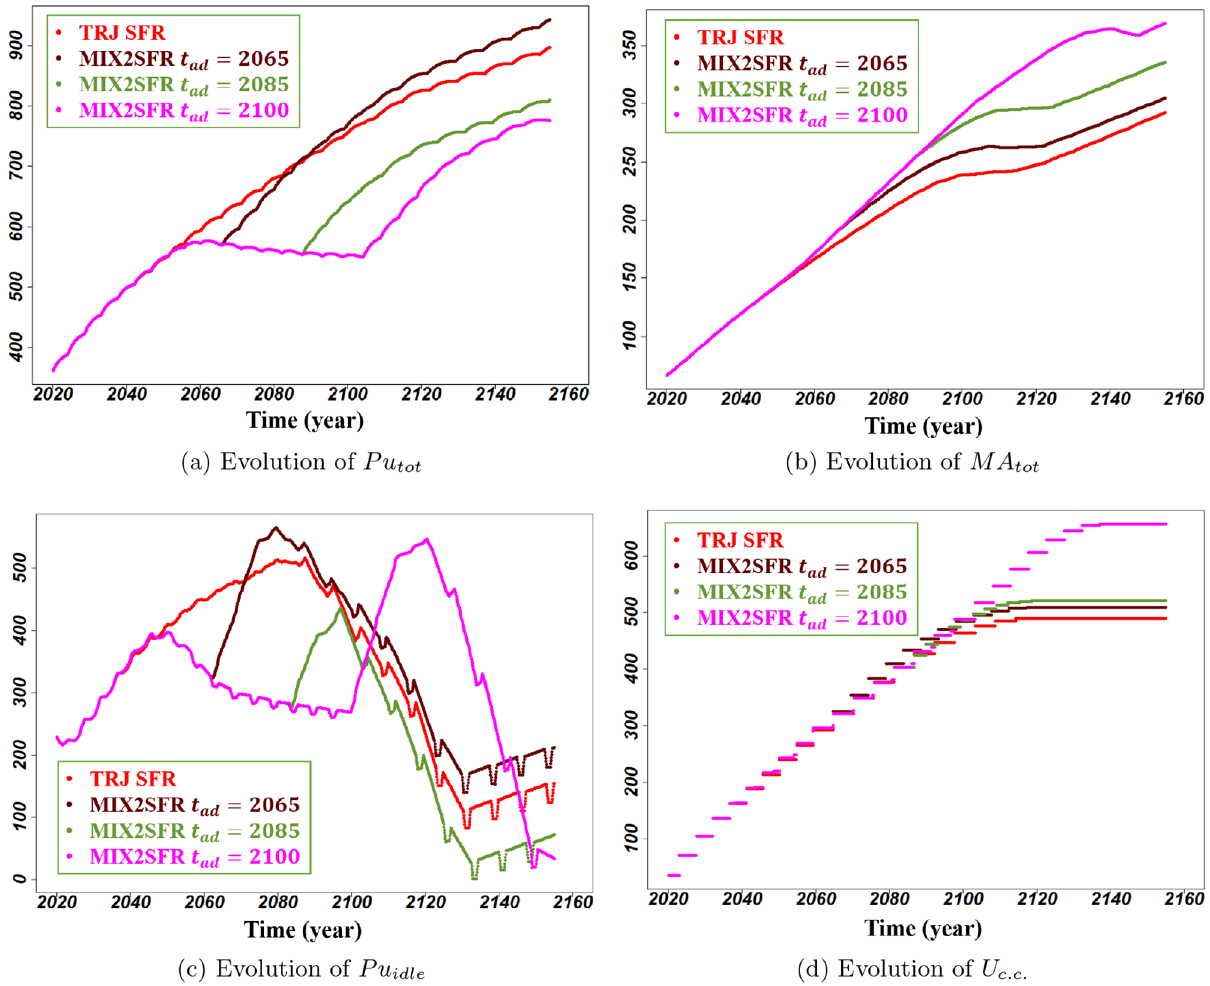
Fig. 7. Evolution of Pu tot , MA tot , Pu idle (in t) and U c.c. (in kt) from optimal adaptive strategies for three t ad in SCN MIX2SFR , compared with that in TRJ SFR . 4. Parameters of optimal adaptive strate- gies minimizing Pu idle,max for three t ad in